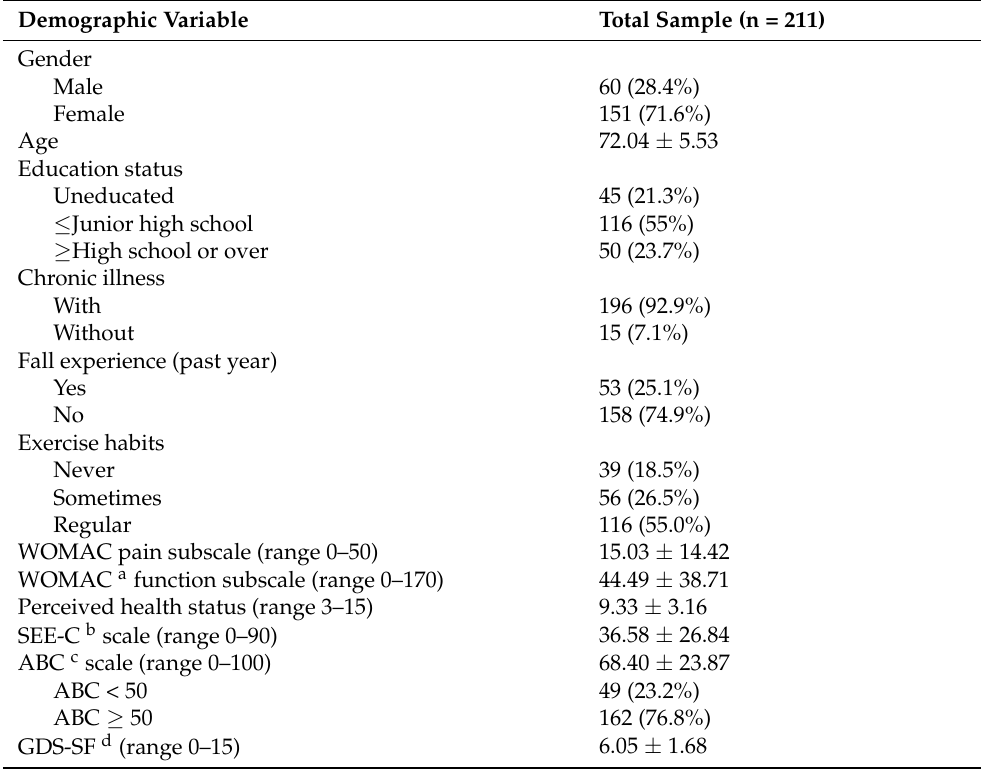
Table 1. Participants’ demographic information and research variable